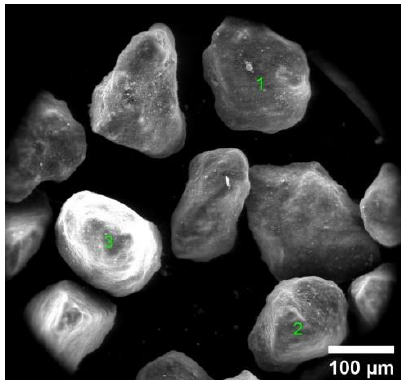
Figure 2. SEM image of